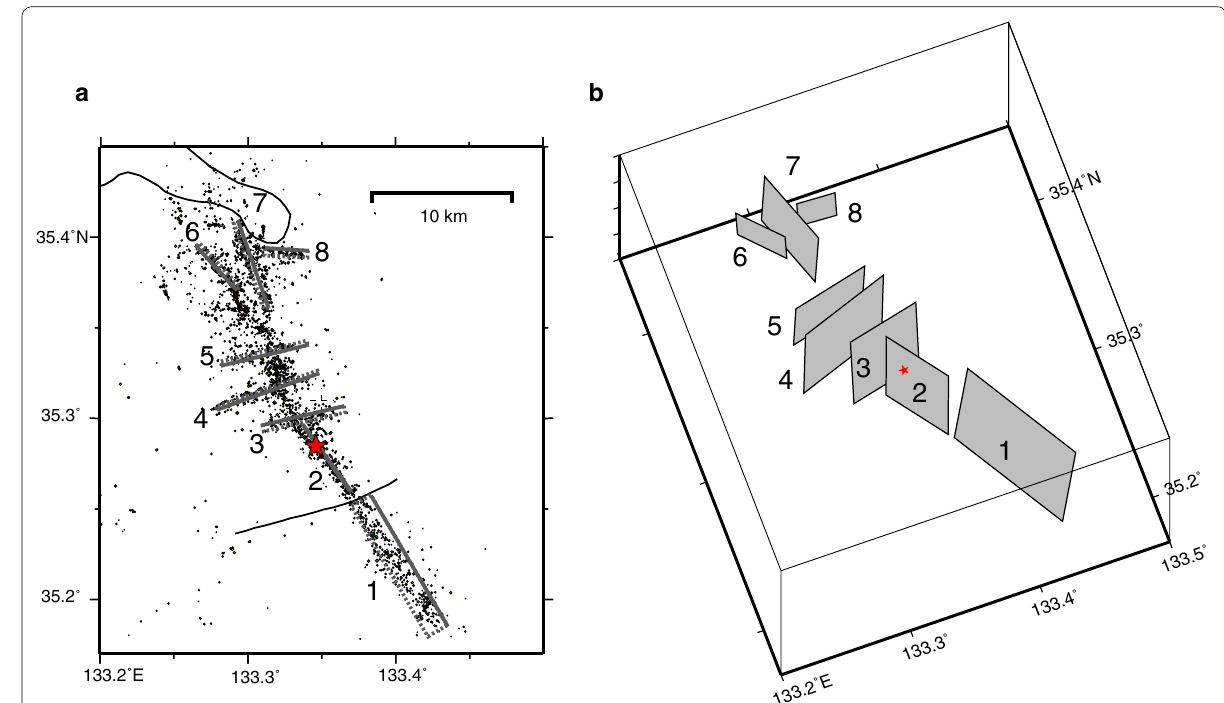
Fig. 4 Best-fit fault planes of the 2000 Western Tottori Earthquake by PCA. a Map view with the relocated aftershock hypocenters. b Perspective view of fault orientations. Numbers correspond to the index numbers of faults listed in Table